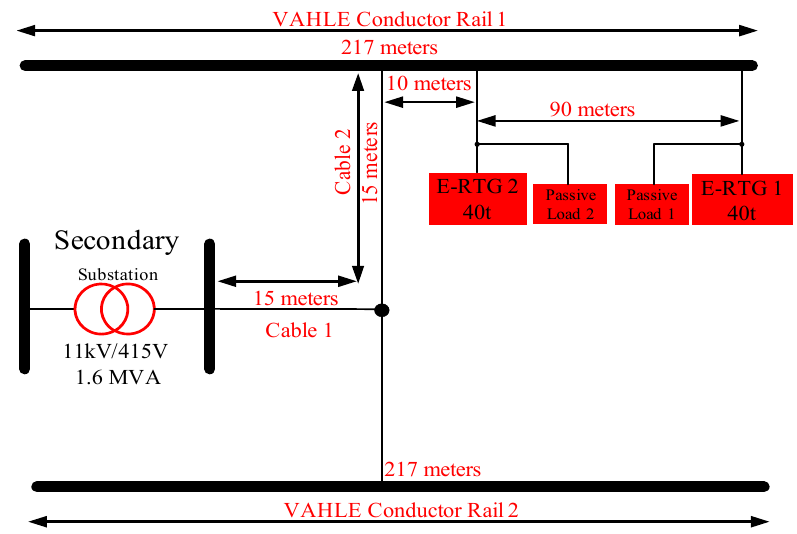
Figure 3. The structure of two RTG cranes connected in series to the secondary substation.